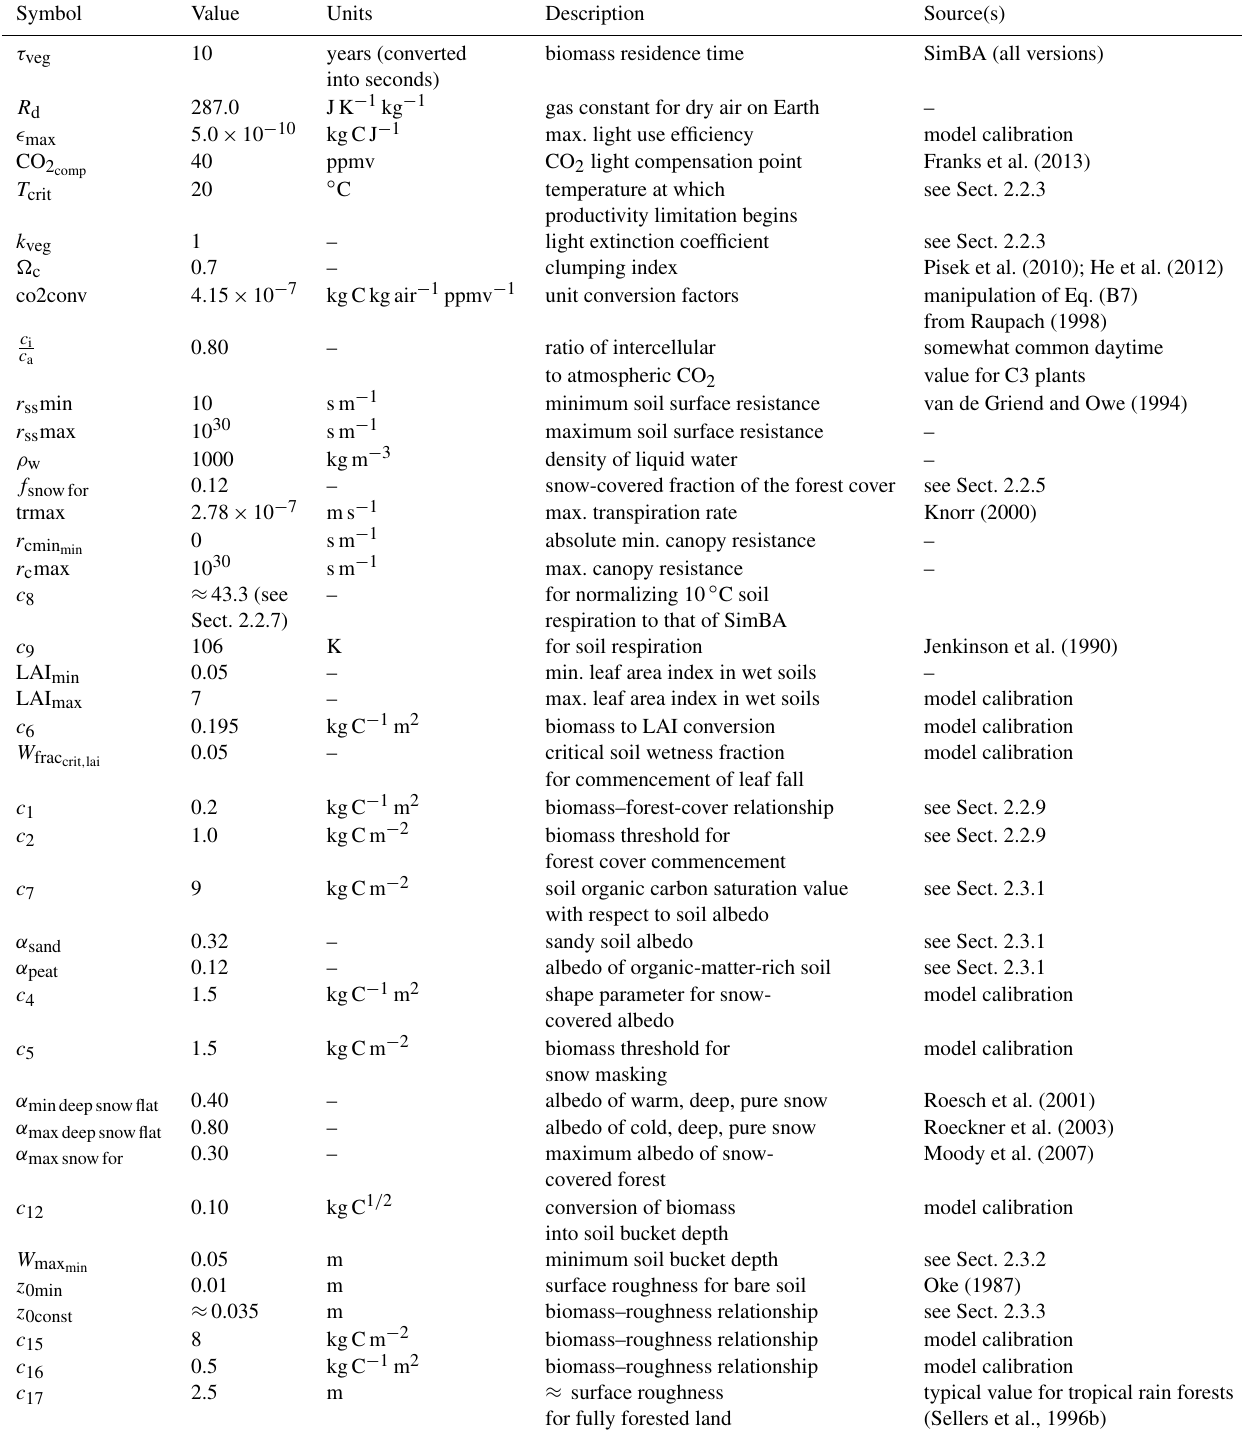
Table 2. SEDGES parameters in the